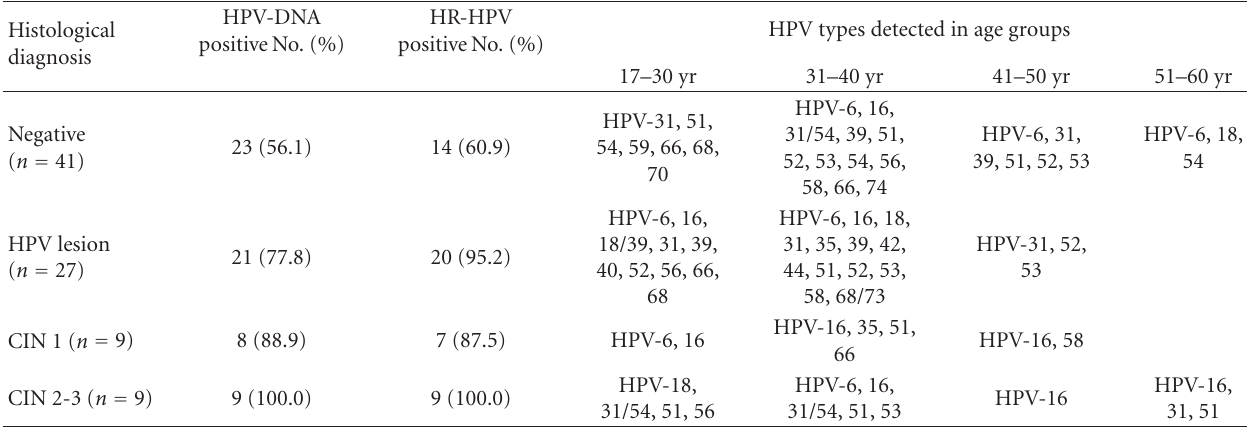
Table 2: HPV prevalence and type distribution in di ff erent histological